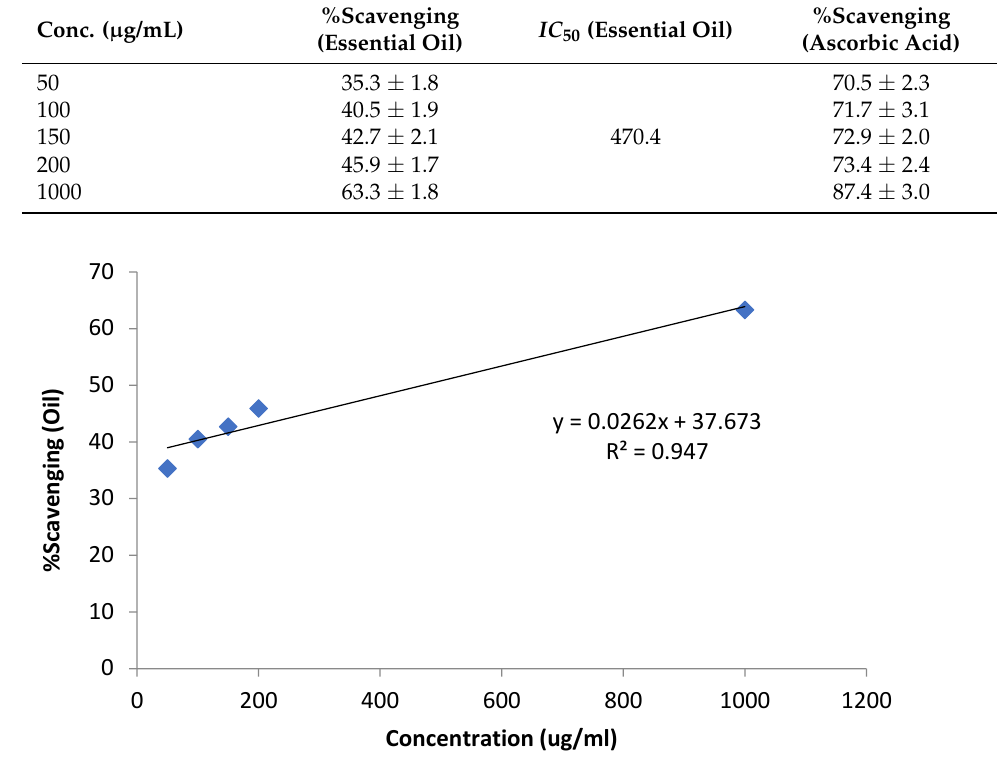
Figure 6. Equation to determine the IC 50 values of essential oil. Table 3. Phytotoxic activity of U. dioica essential Table 2. Antioxidant activity of U. dioica essential oil.